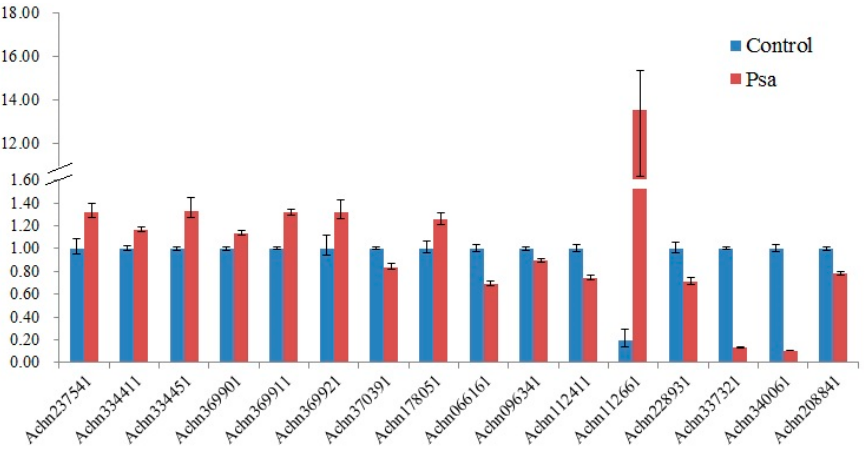
Figure 4. Expression level of 16 NBS-LRR genes. Kiwifruit cultivar “Hongyang” ( A. chinensis var. chinensis ) was used. Shoots were collected from 5 kiwifruit trees and stuck in MS medium. Psa was injected into the stems after they were carved with a knife. Phloem was collected after 48 h with three biological replicates.